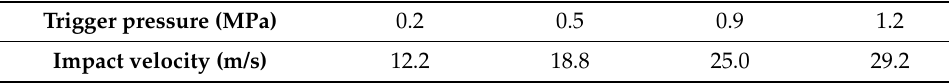
Table 2. Relationship between impact velocity and trigger